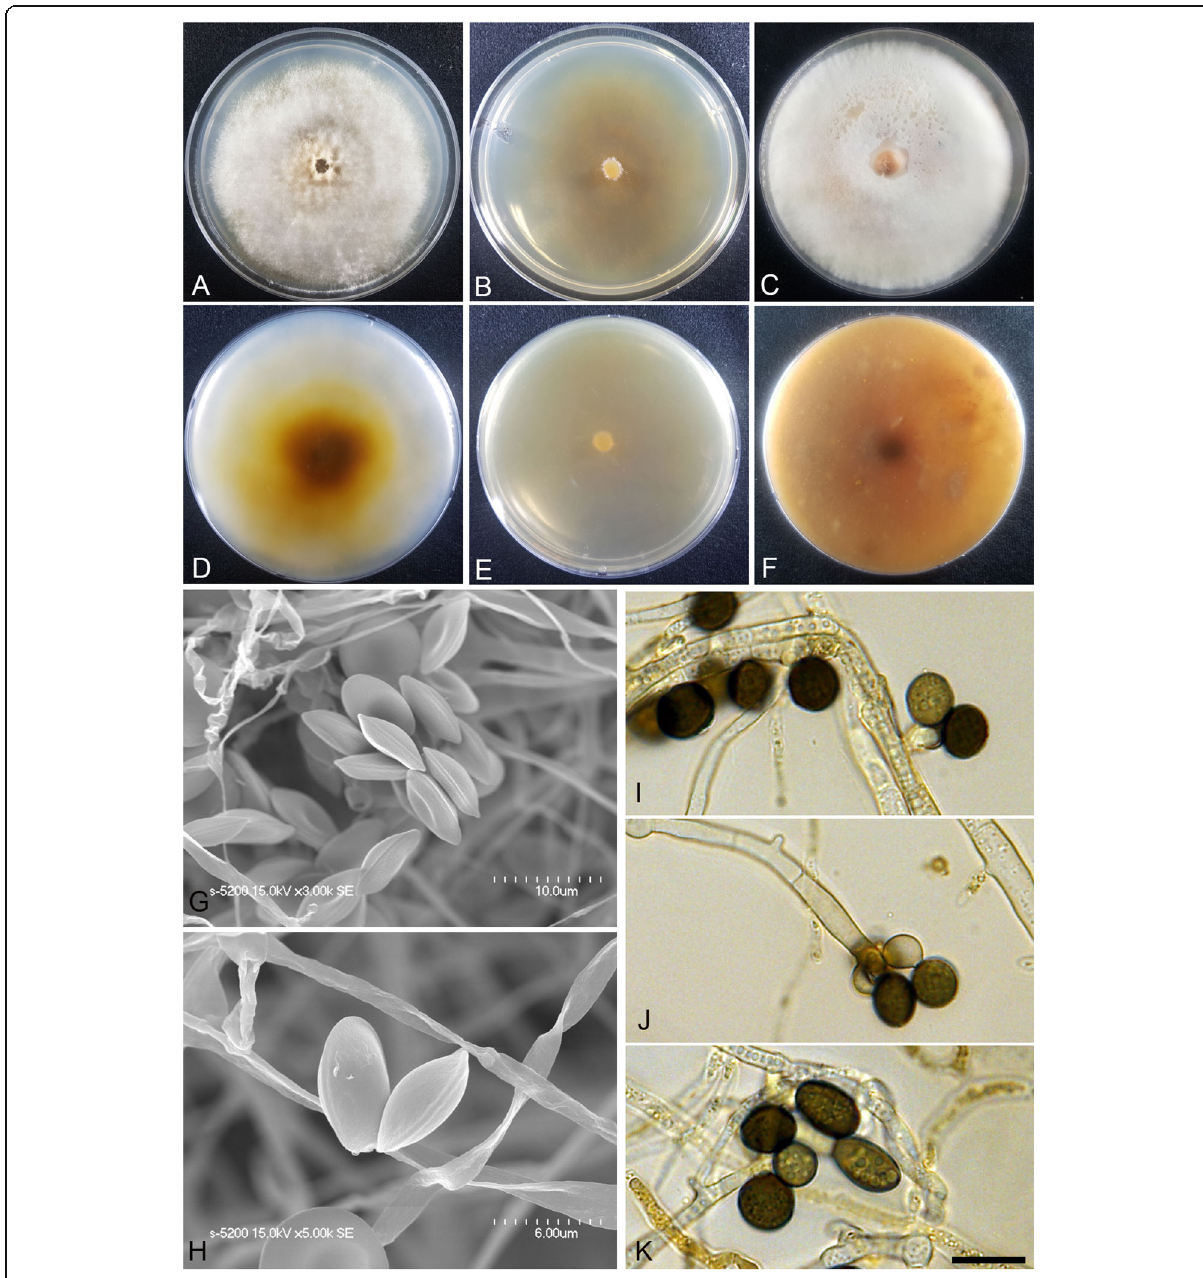
Fig. 5 Arthrinium fermenti (KUC21288). a-c , Colonies on PDA ( a ), MEA ( b ), and OA ( c ) (top); d-f , colonies on PDA ( d ), MEA ( e ), and OA ( f ) (bottom), g-h , conidia under SEM; i-k , conidia attached to conidiogenous cells; scale bar = 10 μ